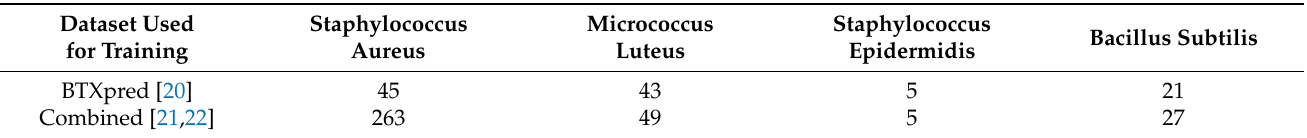
Table 7. Test data results on two models trained using BTXpred data and the combined data of VFDB and